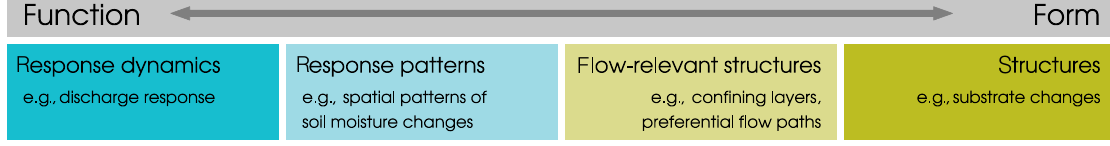
Figure 1. The concept of form and function applied to observations in hillslope hydrology. Four different categories which can be applied to data as well as the data